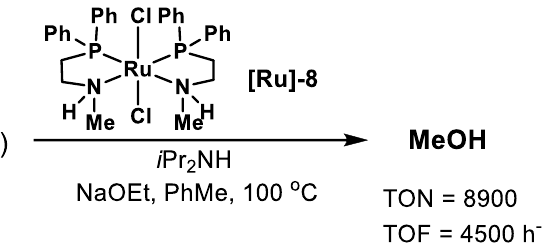
7 of 15 Figure 8. Inorganic base aided Ru-catalyzed hydrogenation of CO 2 .